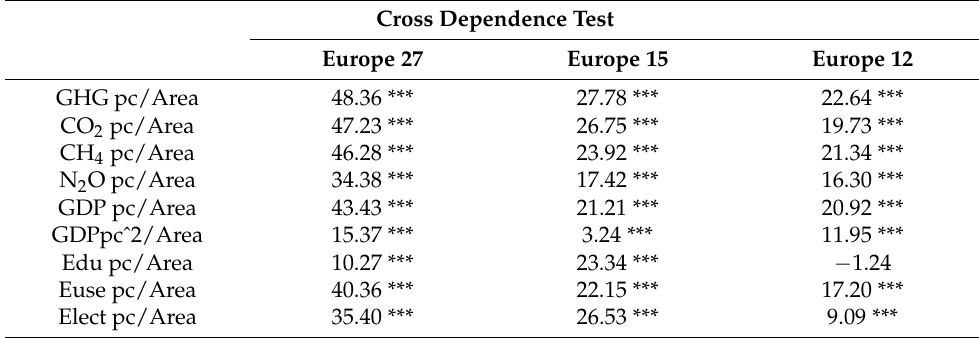
Table 2. Cross dependence (CD) test results by European group.